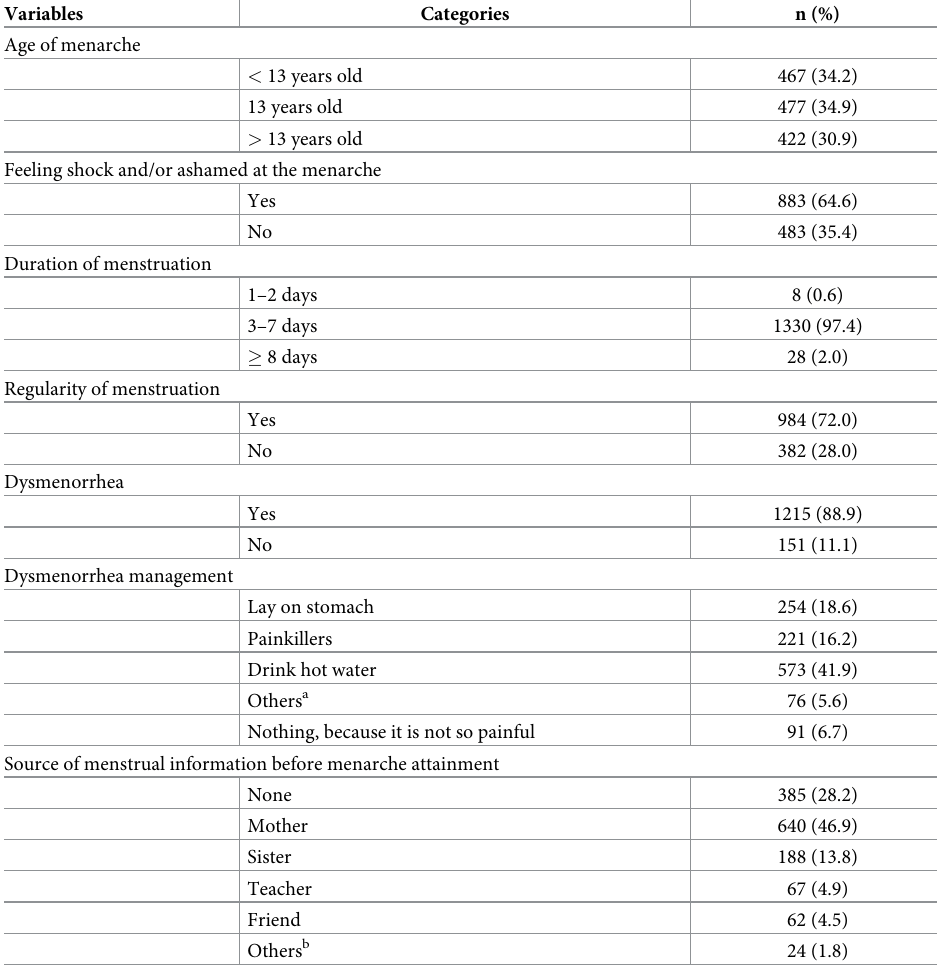
Table 2. Reproductive characteristics of secondary school girls in Luang Prabang Province (N =